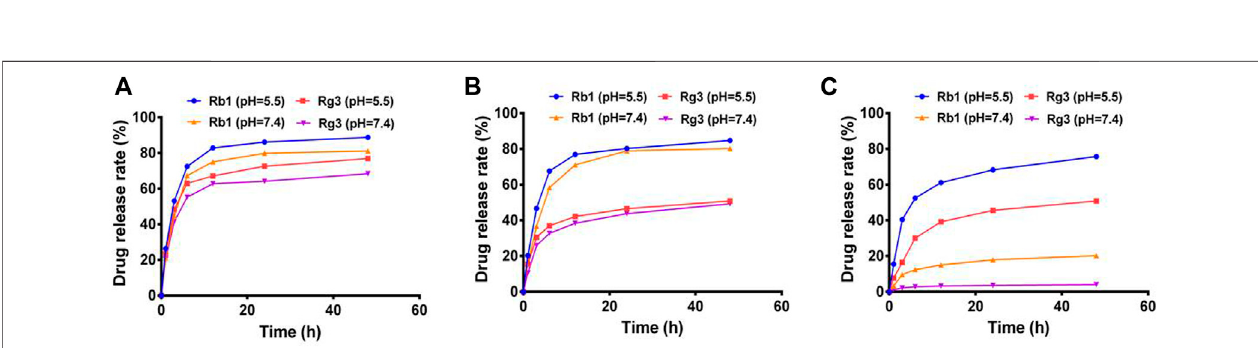
FIGURE2 | Drug release pro fi les ofRg3-Rb1 NPsofdifferentweightratios (Rb1to Rg3) under acidic and neutral pH conditions. (A) 1:1, (B) 3:1, and (C) 5:1. NPs, nanoparticles.